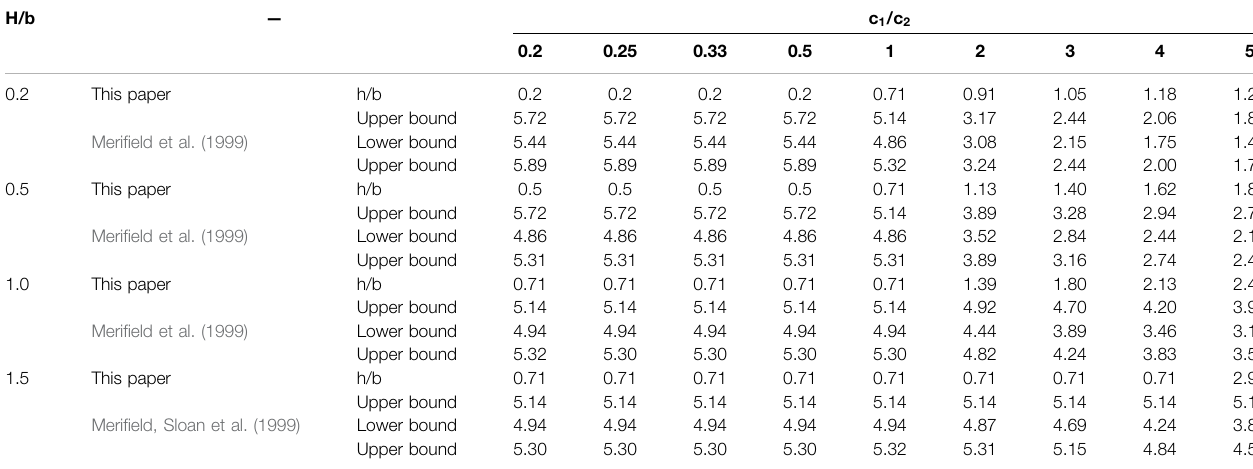
TABLE 3 | Statistics of ultimate bearing capacity coef fi